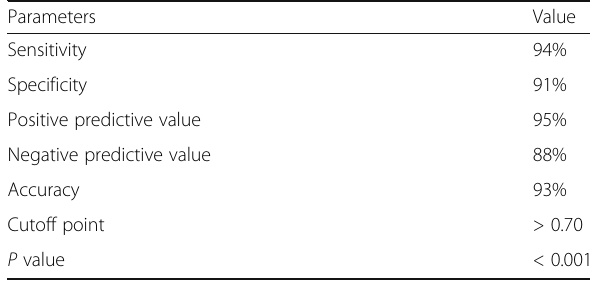
Table 2 Diagnostic accuracy of HLA-G in diagnosing GDM Parameters Value Sensitivity 94% Specificity 91% Positive predictive value 95% Negative predictive value 88% Accuracy 93% Cutoff